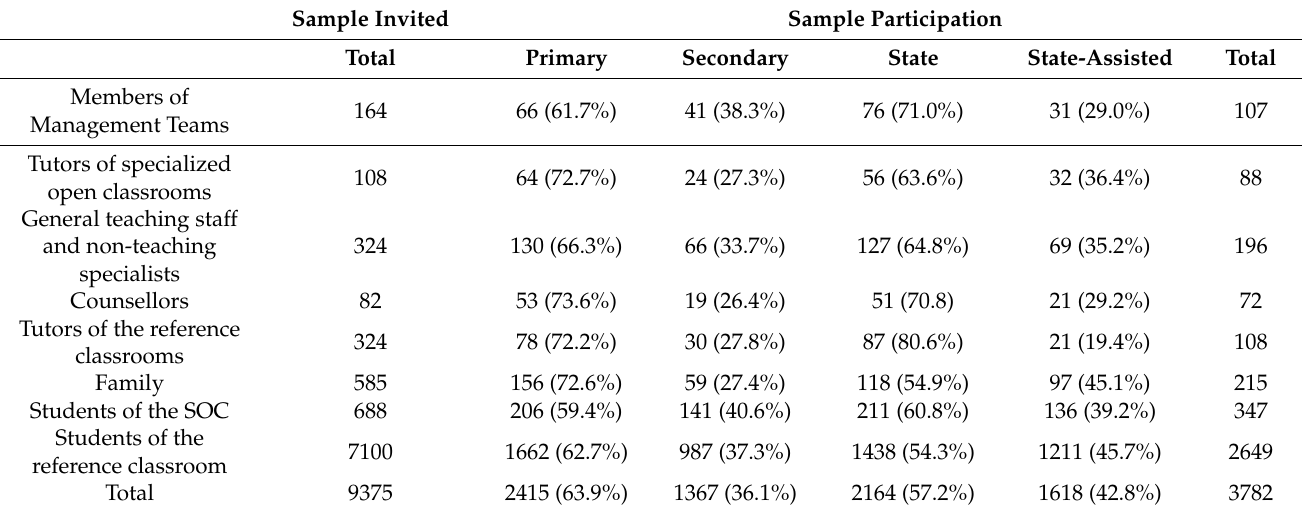
Table 1. Sample participating in the